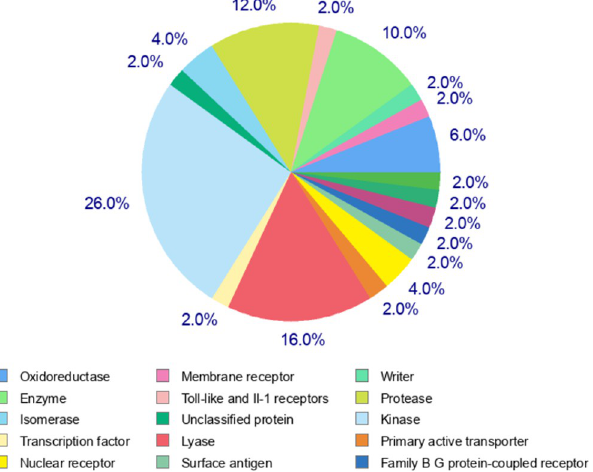
Fig 10. Relative abundance of the class of top 50 predicted molecular targets of curcumin obtained from SwissTargetPrediction.